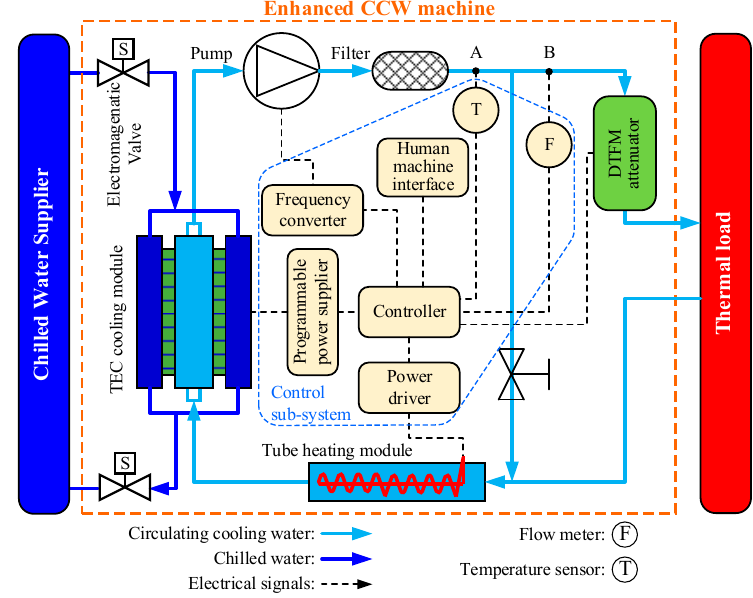
Figure 1. Scheme of an enhanced circulating cooling water (CCW) machine.